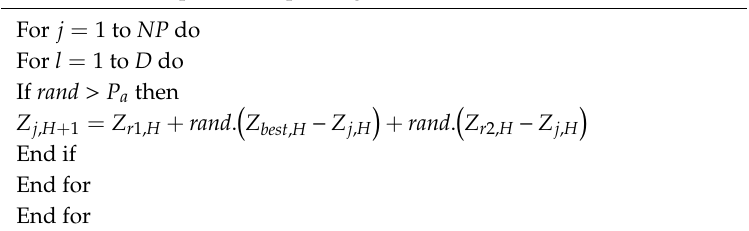
Algorithm 1: Population Updating